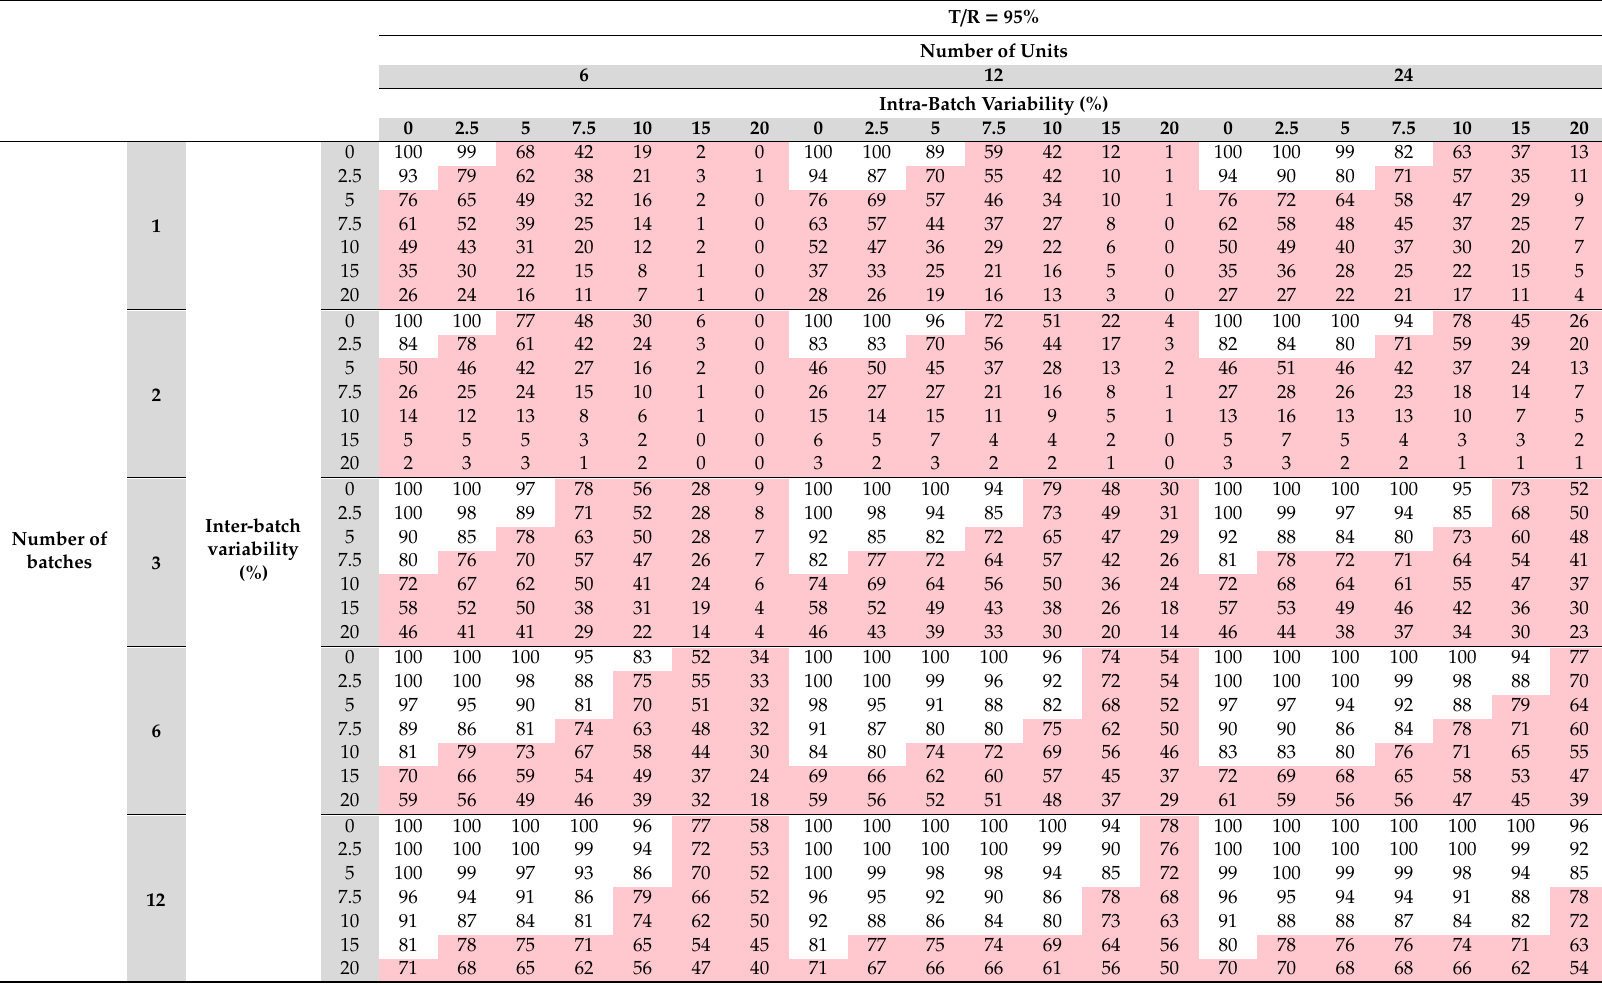
Table 3. Probability of similarity when the population di ff erence between reference and test products is 5%. Number of batches and inter-batch variability are depicted in the left margin and number of replicates and intra-batch variability on the top of the table. In red are outlined the scenarios with a probability lower than